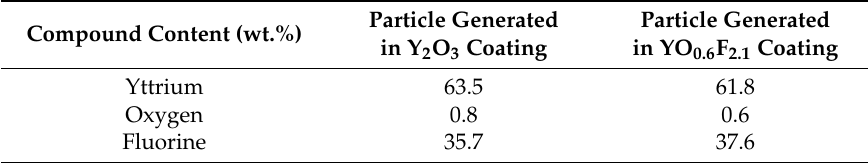
Table 2. EDS analysis results of contamination particles generated in Y 2 O 3 and YO 0.6 F 2.1 coatings after exposure to the NF 3